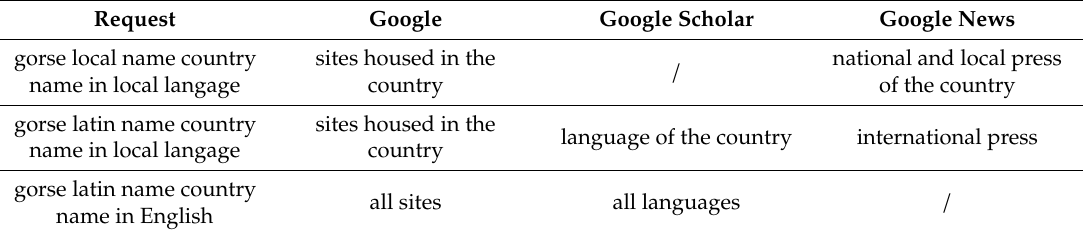
Table 1. Details of the research carried out to identify the status of gorse in the countries